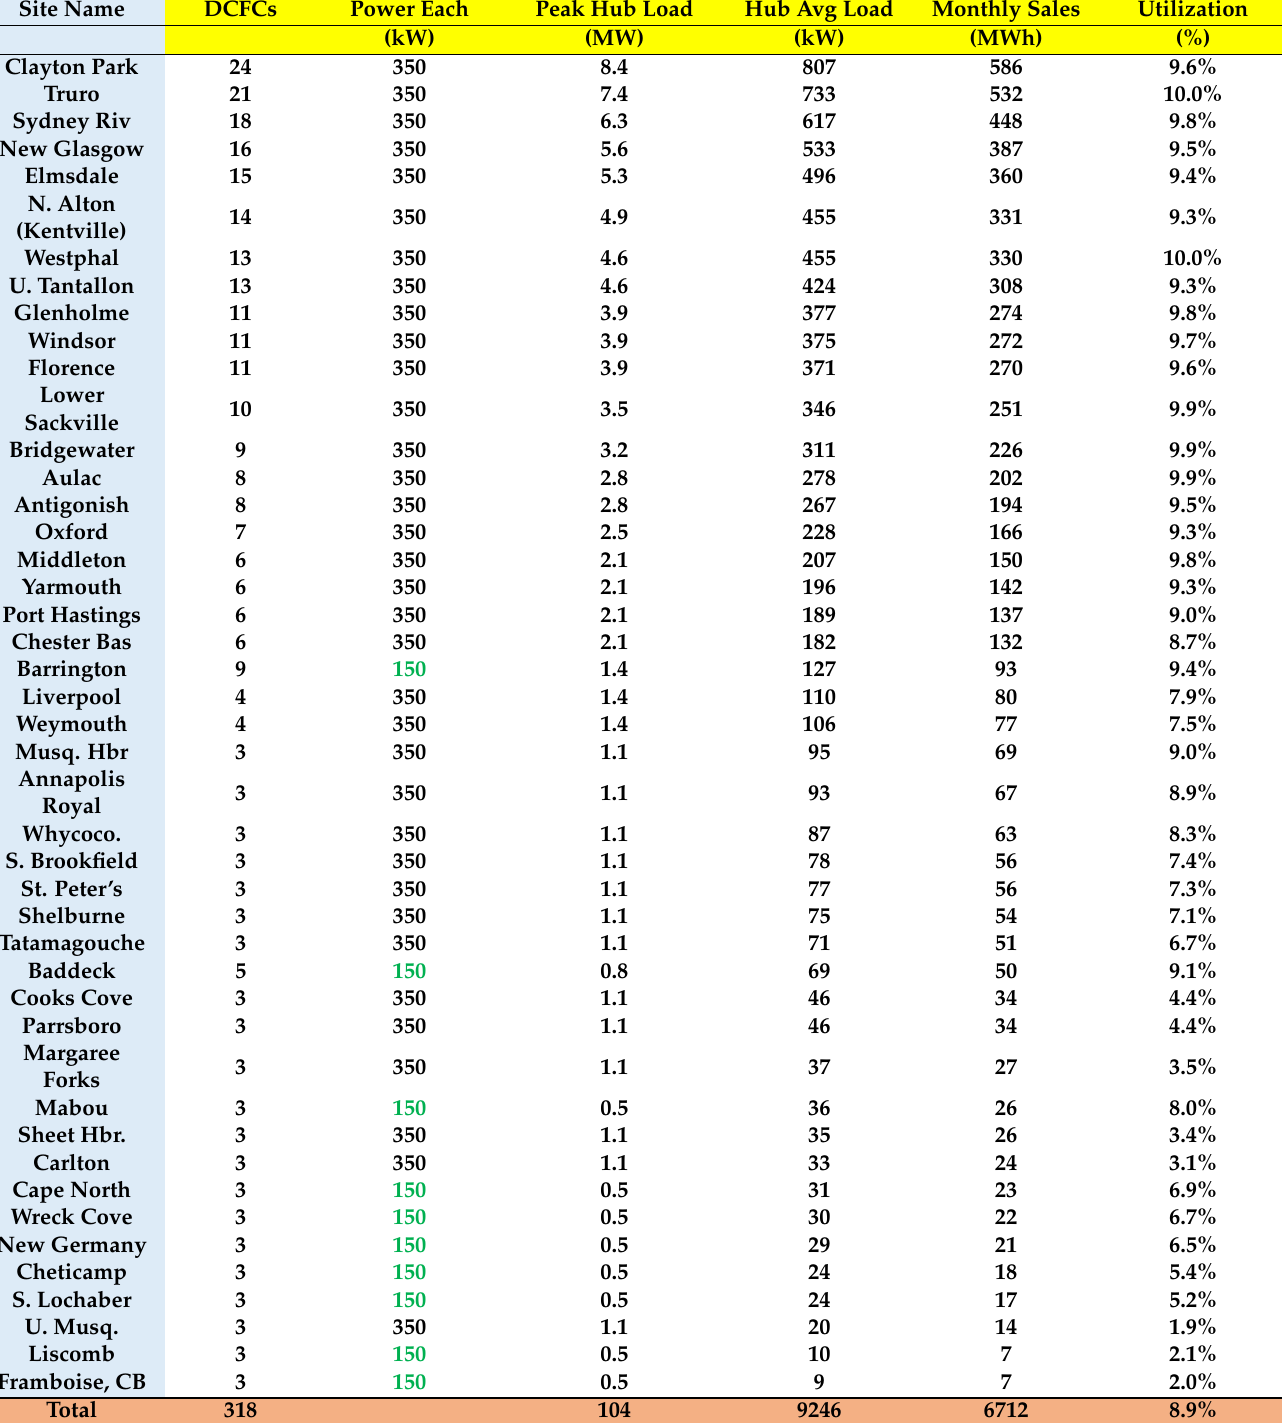
Table 2. Listing of charging hub with DCFC count, DCFC power, potential peak power draw, average electricity consumption, monthly electricity sales, and average